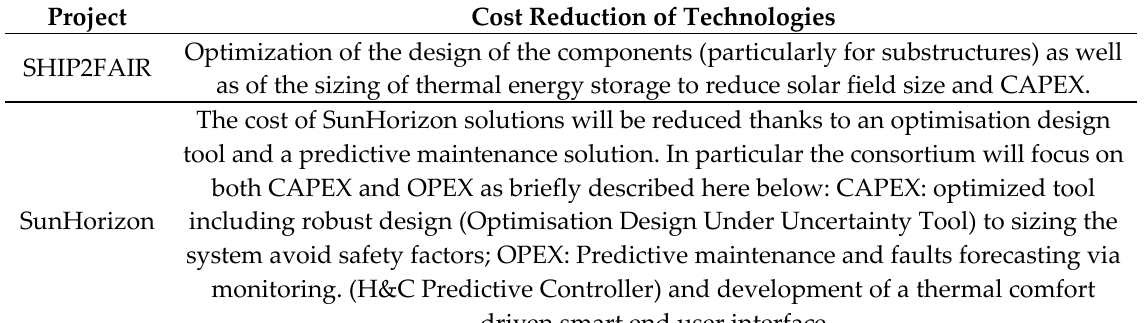
Table 4. Cost reduction of